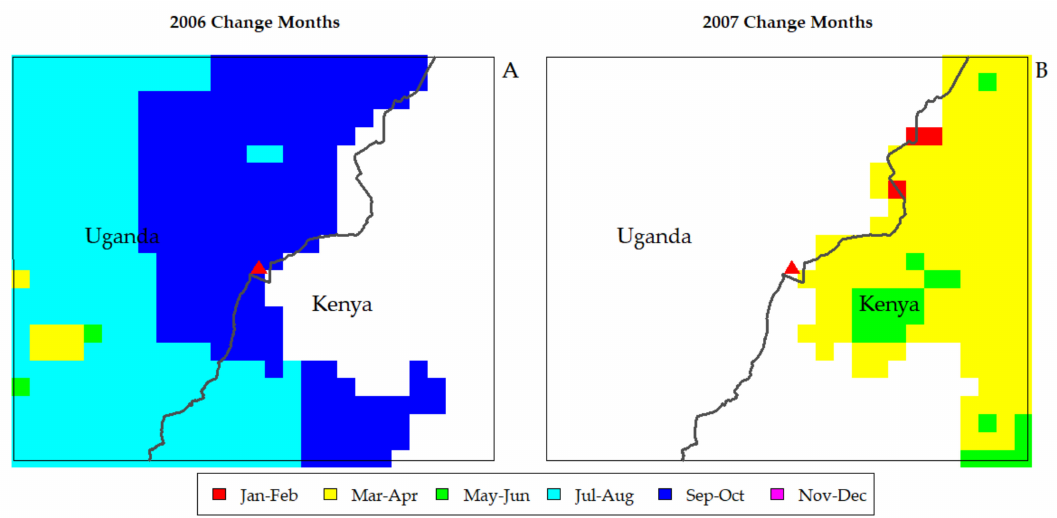
Figure 9. ( A , B ) Months when major breaks were detected in the precipitation time series (2001–2008) when the period 2005–2008 was monitored.